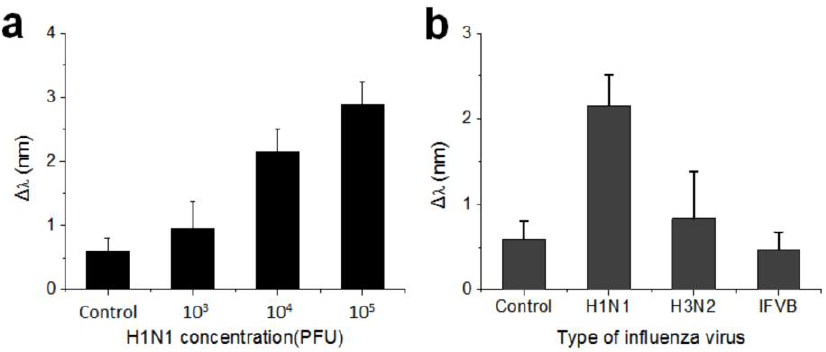
Figure 4. ( a ) The magnitude of reflectance peak shift as a function of H1N1 subtype concentration, where the concentration was varied in the range of 10 3 to 10 5 PFU in 10 μL ( n = 3). Phosphate-buffered saline (PBS) buffer solution is used for the control; ( b ) The magnitude of reflectance peak shift